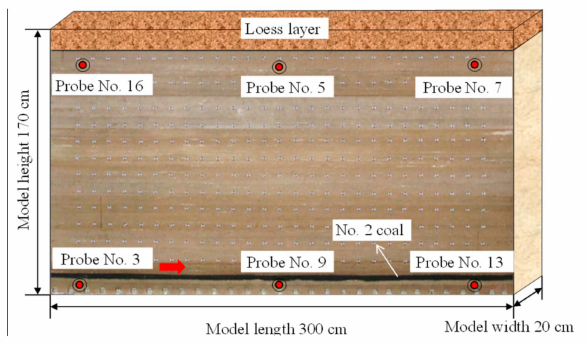
Figure 2. The arrangement of microseismic monitoring